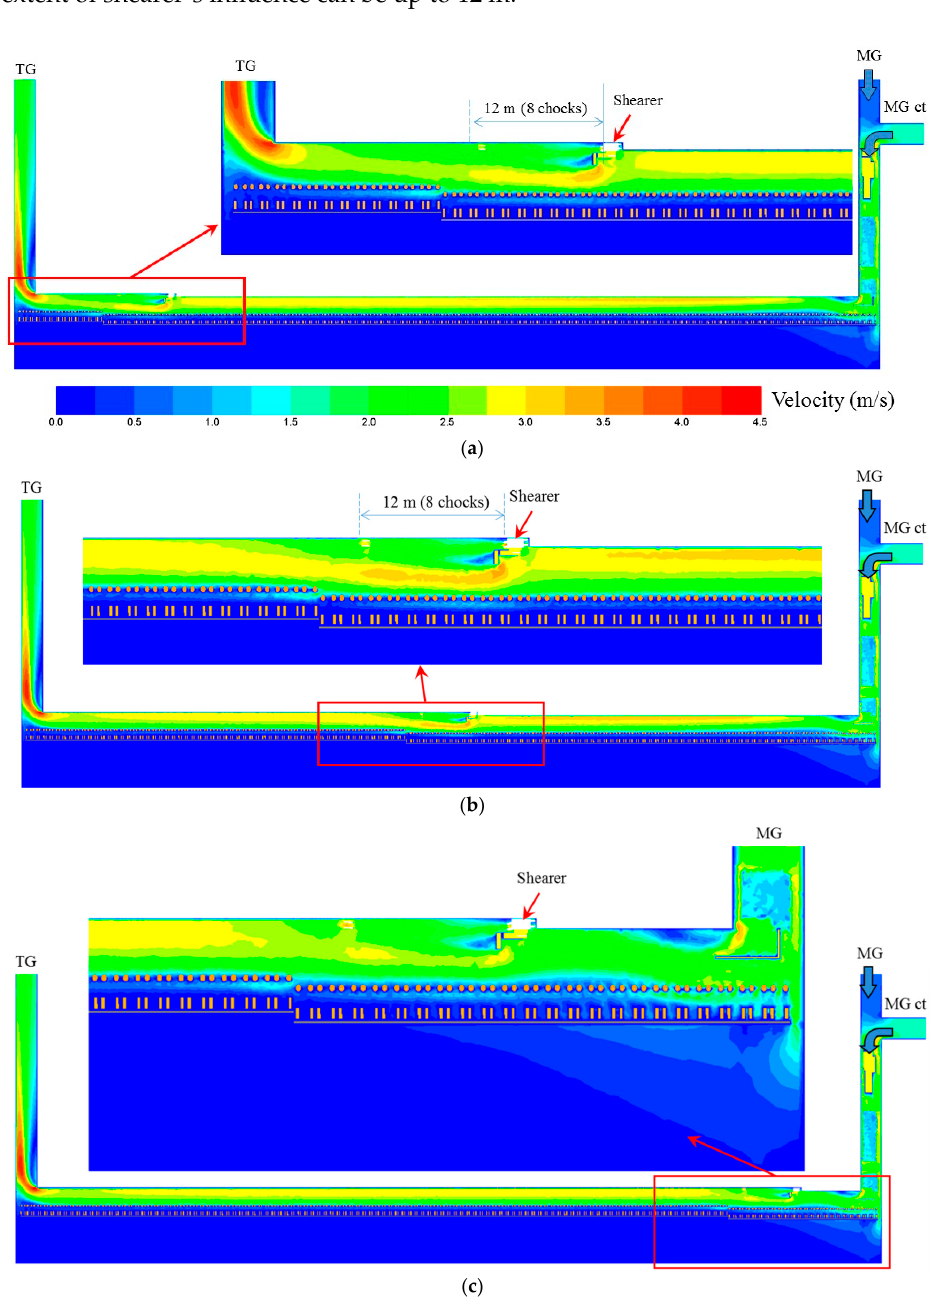
Figure 12. Velocity contour at 2 m above floor for TG-MG Cases: ( a ) TG-MG Case 3; ( b ) TG-MG Case 2; ( c ) TG-MG Case 1. ( c ) TG-MG Case